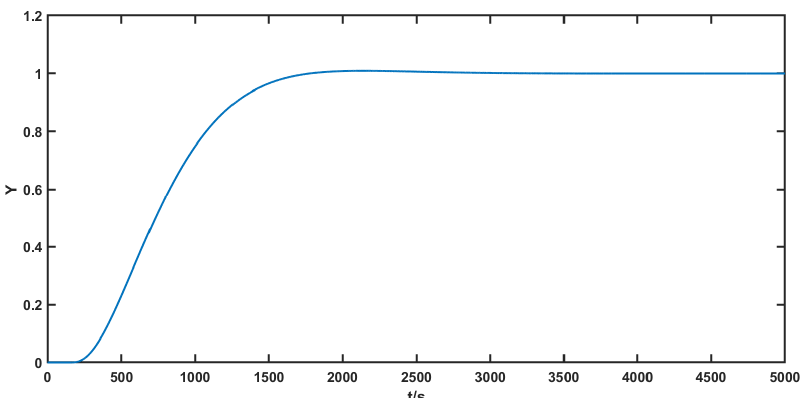
ω = c = 0.0473 when K